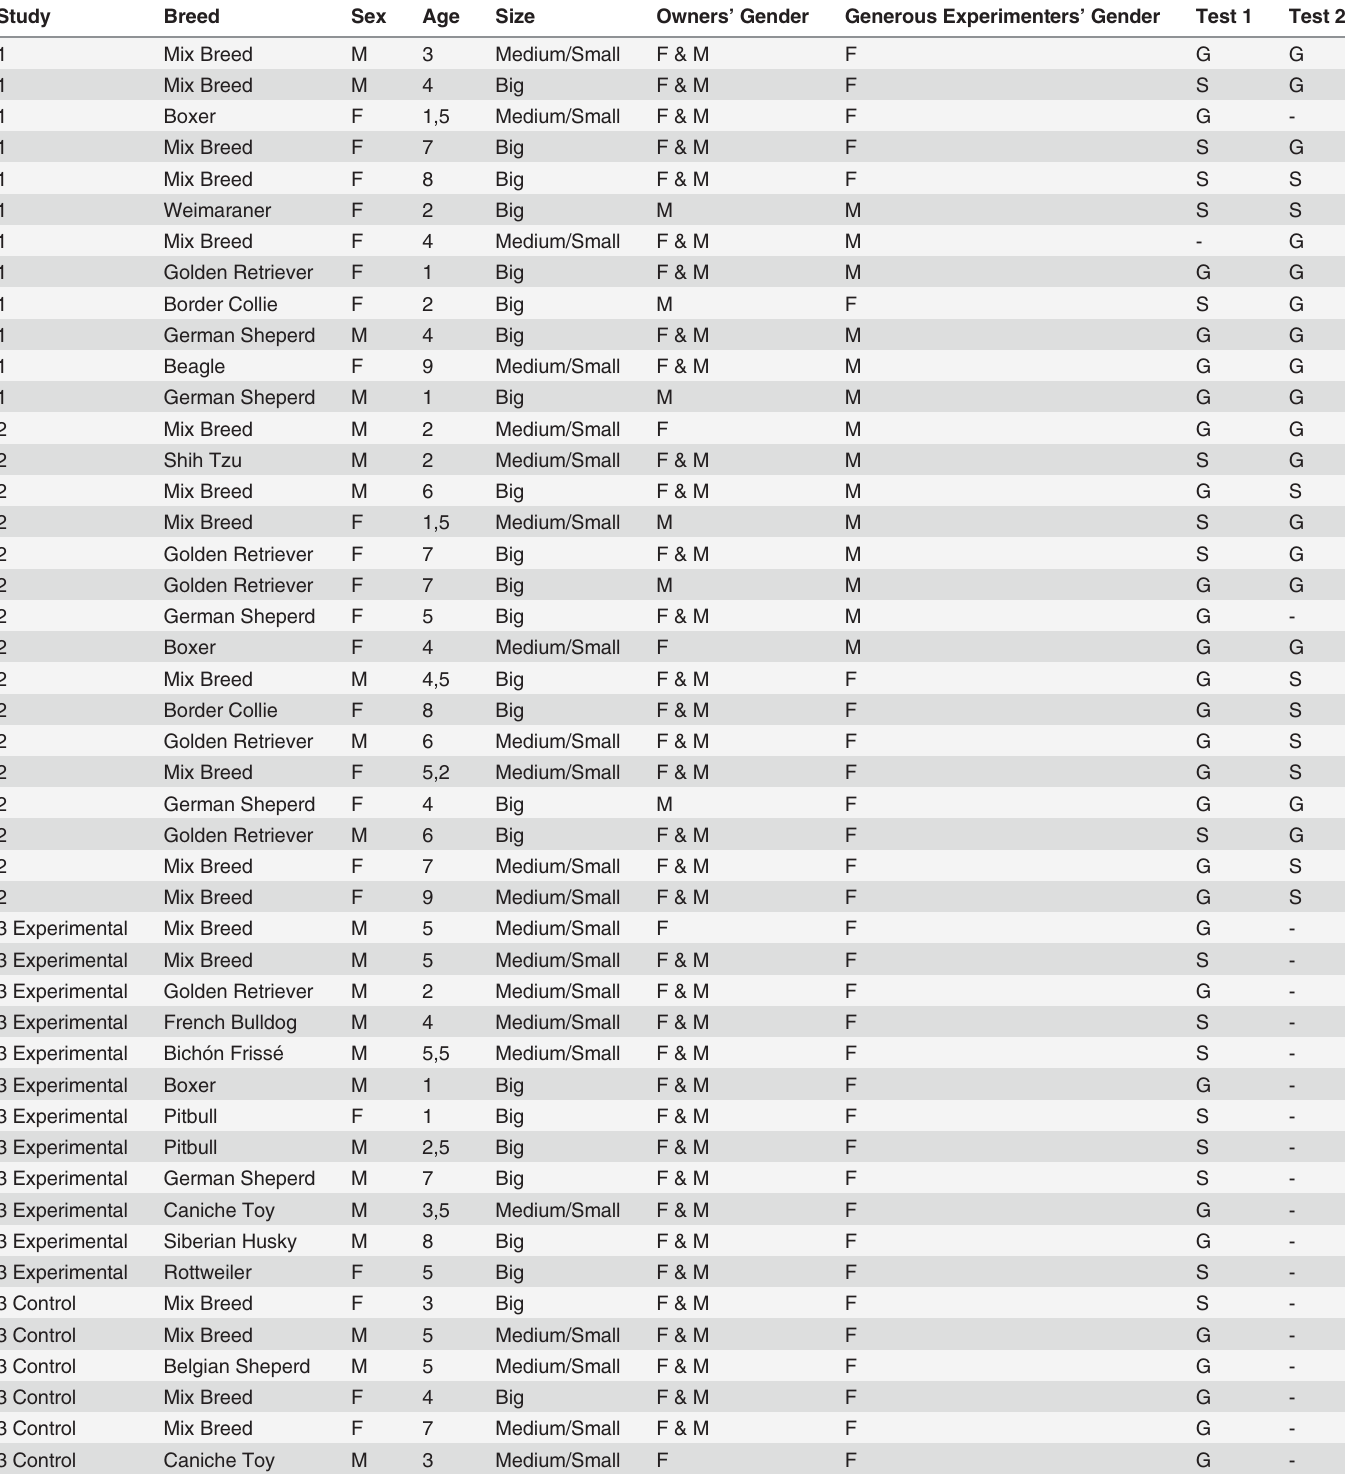
Table 1. Subjects ’ details and choices in the test phase.